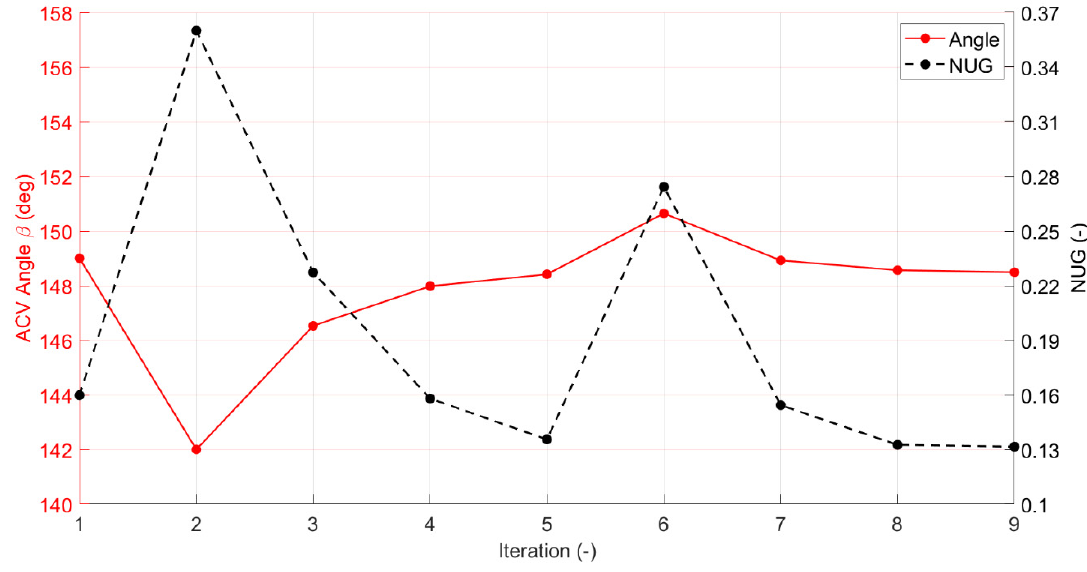
Figure 18. Optimization process trend.